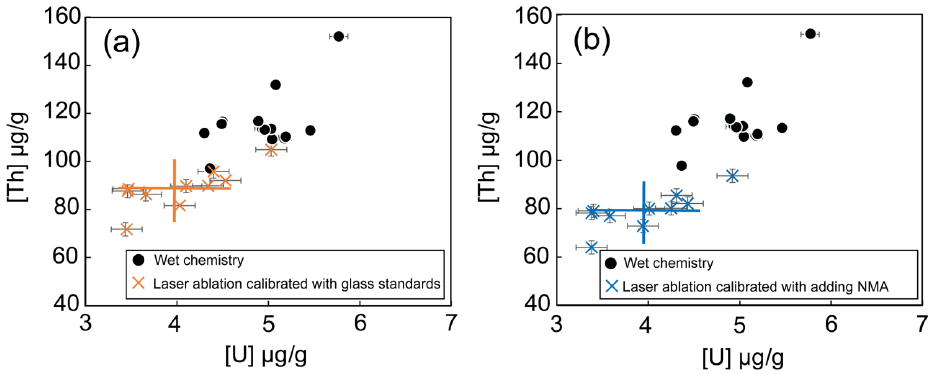
Figure 8. U and Th content obtained by wet chemistry and laser ablation methods. (a) Results obtained with silicate glass standards (orange crosses) and (b) with addition of NMA as standard materials (blue crosses). Wet chemistry data are represented by the black